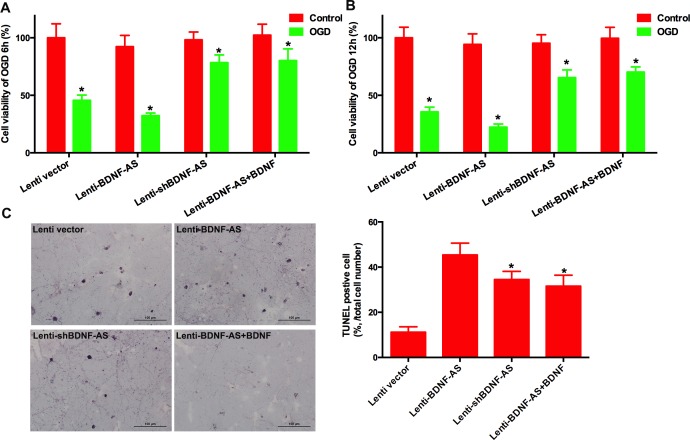
Inhibition of BDNF-AS protected RGCs against ischemia.The MTT method was used to determine cell viability. (A) Lenti-BDNF-AS significantly decreased cell viability while the lenti-shBDNF-AS reversed this trend. The effect of lenti-BDNF-AS on cell viability could be reversed by exogenous BDNF protein. (B) When RGCs were exposed to 12 hof OGD, similar results were observed. (C) The TUNEL method was used to measure apoptosis. The number of TUNEL-positive cells was increased by lenti-BDNF-AS but decreased by lenti-shBDNF-AS compared with the empty vector. The effect of lenti-BDNF-AS was also blocked by exogenous BDNF protein treatment. Scale bar, 100μm; P<0.05 was considered significantly different; * vs control group.